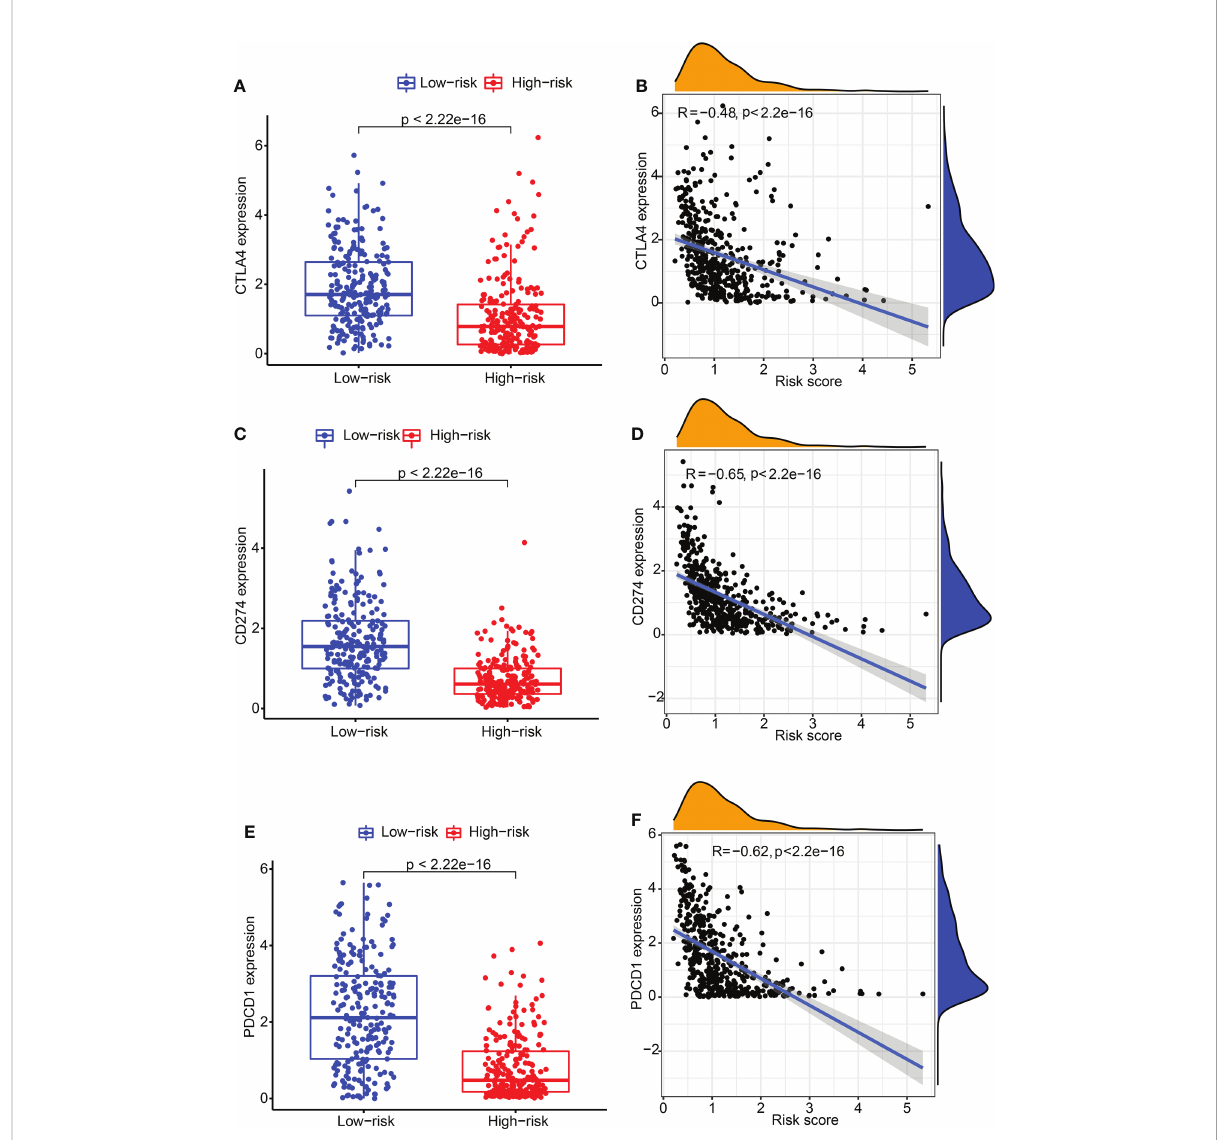
FIGURE 4 The expression of CTLA4 and CD274 in high- and low-CDIGPM groups. (A) CTLA4 expression in high- and low-CDIGPM groups. (B) Correlation analysis between CDIGPM and CTLA4 expression. (C) CD274 expression in high- and low-CDIGPM groups. (D) Correlation analysis between CDIGPM and CD274 expression. (E) PDCD1 expression in high- and low-CDIGPM groups. (F) Correlation analysis between CDIGPM and PDCD1 expression. CDIGPM: CD8 + T cells-associated immune genes prognostic